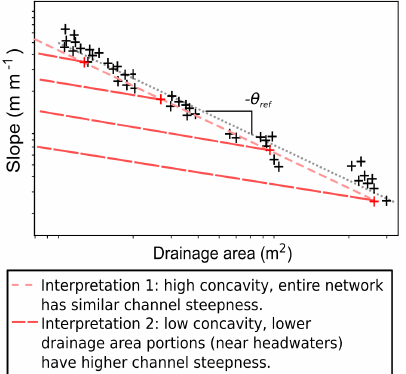
Figure 1. Sketch illustrating the effect of choosing different refer- ence concavities. The data can be well fitted with a single regres- sion, suggesting that all parts of the channel network have similar values of k sn (interpretation 1). However, if a lower θ ref is chosen, the k sn values will be systematically higher for channels at lower drainage area (interpretation 2). This sketch is based on data from a numerical simulation where the latter situation has been imposed via higher uplift rates in the core of the mountain range, showing the potential for incorrect concavities to be extracted from slope–area data alone.